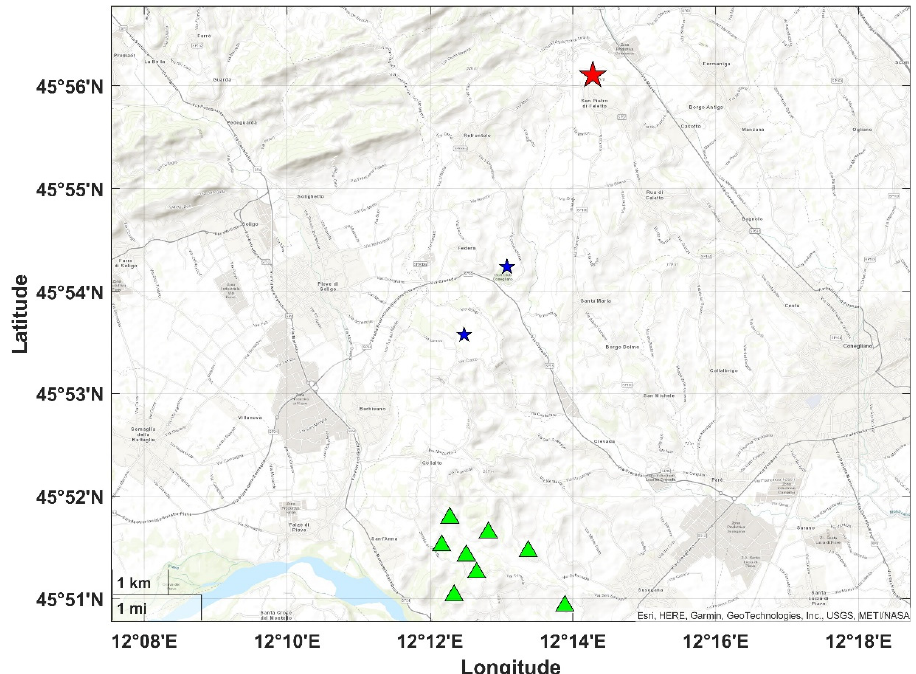
Figure 4. Location of the events detected by FAST and included in the OGS catalogue in the vicinity of the array. Blue stars represent the events 9 and 10 in Table 1, while the red star represents the event 15 in Table 1. The size of the stars is proportional to the magnitude of the events and the green triangles mark the position of the array stations.